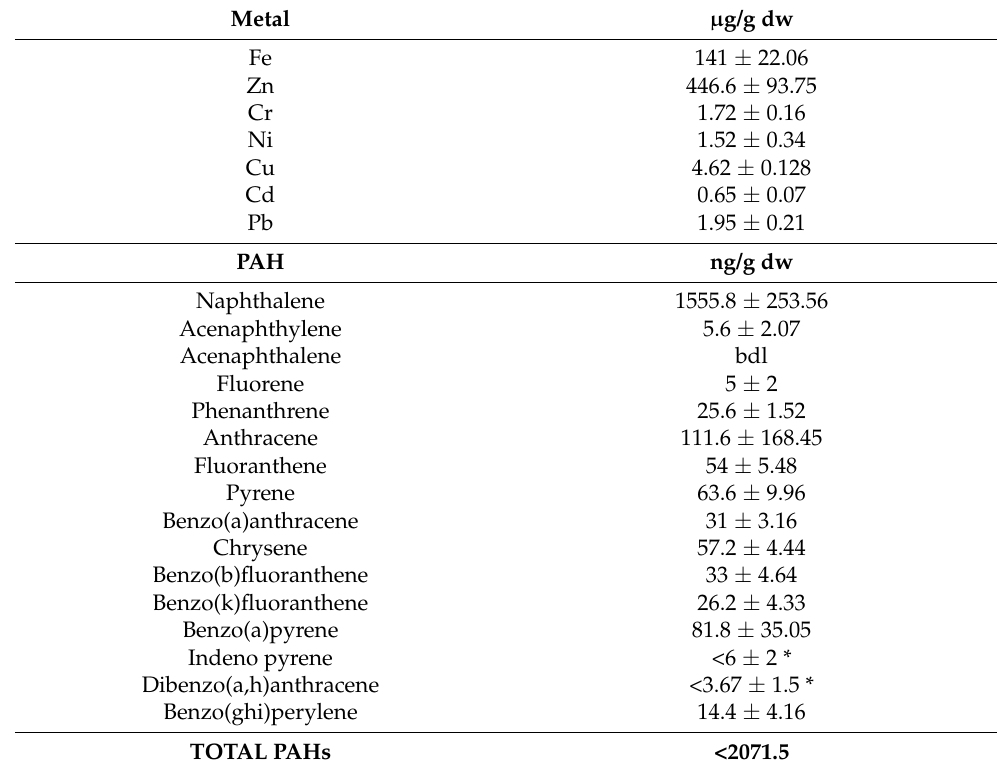
Table 2. Results of the chemical analyses of mussels sampled in Plentzia (Bay of Biscay) in March 2016. Data are expressed as mean ± standard deviation.